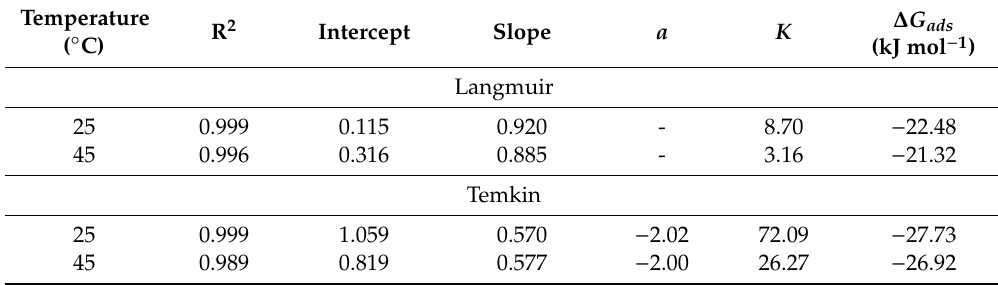
Table 3. Parameters of the linear regression from Langmuir and Temkin adsorption isotherms at 25 and 45 ◦